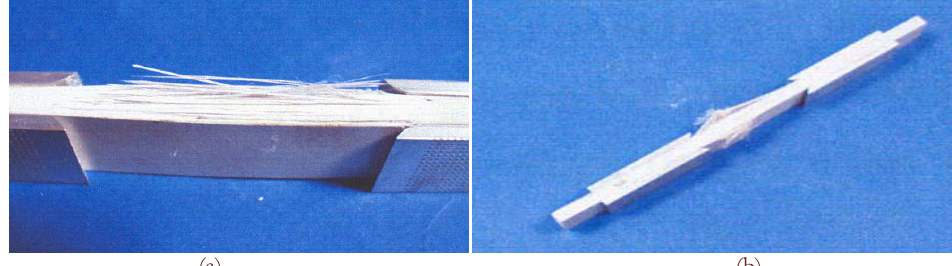
Figure 6: Typical aspect of a DGM failure: (a) tensile failure, (b) compression